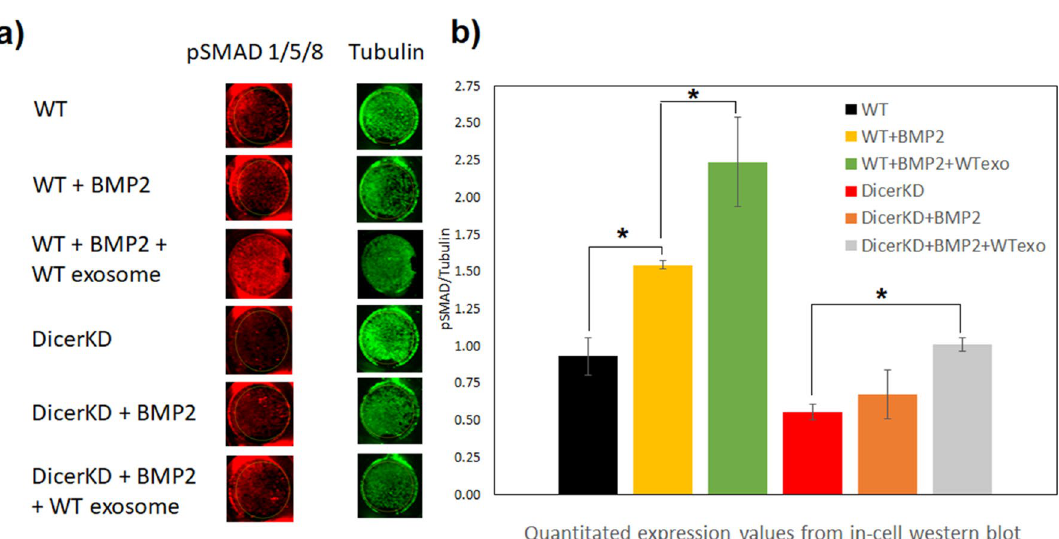
Figure 5. SMAD1/5/8 Phosphorylation in response to rhBMP2 treatment. ( a ) Representative images of individual wells showing phosphorylated SMAD1/5/8 staining (red) and corresponding tubulin expression (green) (n = 3 per each group). ( b ) Quantitation of the images revealed that SMAD 1/5/8 phosphorylation was significantly impaired (* P < 0.01) in DicerKD hMSCs in the presence of BMP2 compared to WT hMSCs. Complementation of DicerKD cells with WT exosomes significantly increased (* P < 0.01) the phosphorylation of SMAD 1/5/8 four hours post rhBMP2 treatment. While these levels were statistically insignificant with respect to WT cells, ( P > 0.05), the mean value remained lower indicating a partial restoration of BMP2 function with WT exosome complementation. One-way ANOVA and Tukey’s post-hoc test was used for statistical